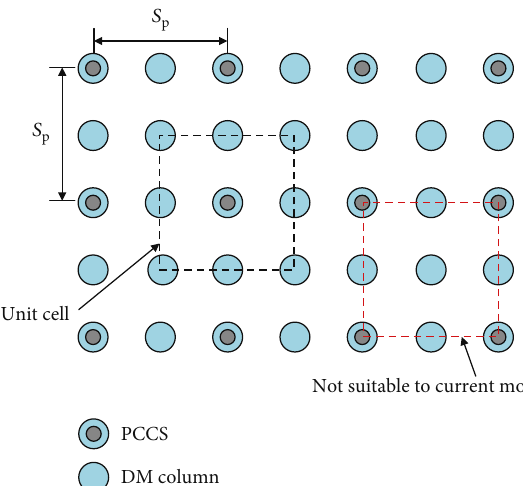
Figure 1: Layout of this CCF reinforced with penetrated PCCSs and fl oating DM